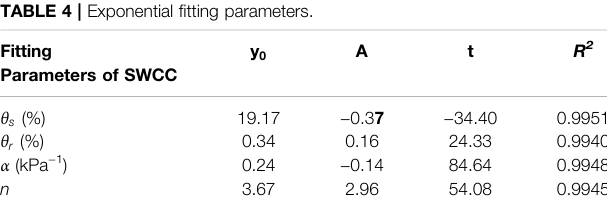
TABLE 4 | Exponential fi tting parameters. Fitting Parameters of